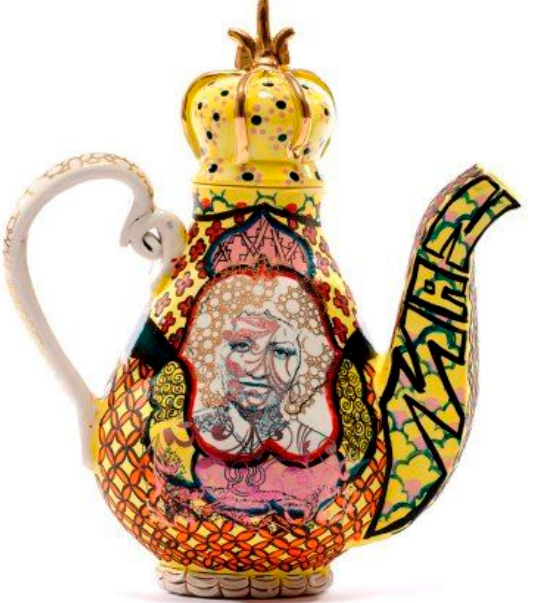
Figure 12. Basquiat/Celia Cruz Teapot , 2016 Porcelain, china paint, gold luster, 12 × 10 × 6 1/2 in. Image by KeneK Photography, courtesy of Wexler Gallery.